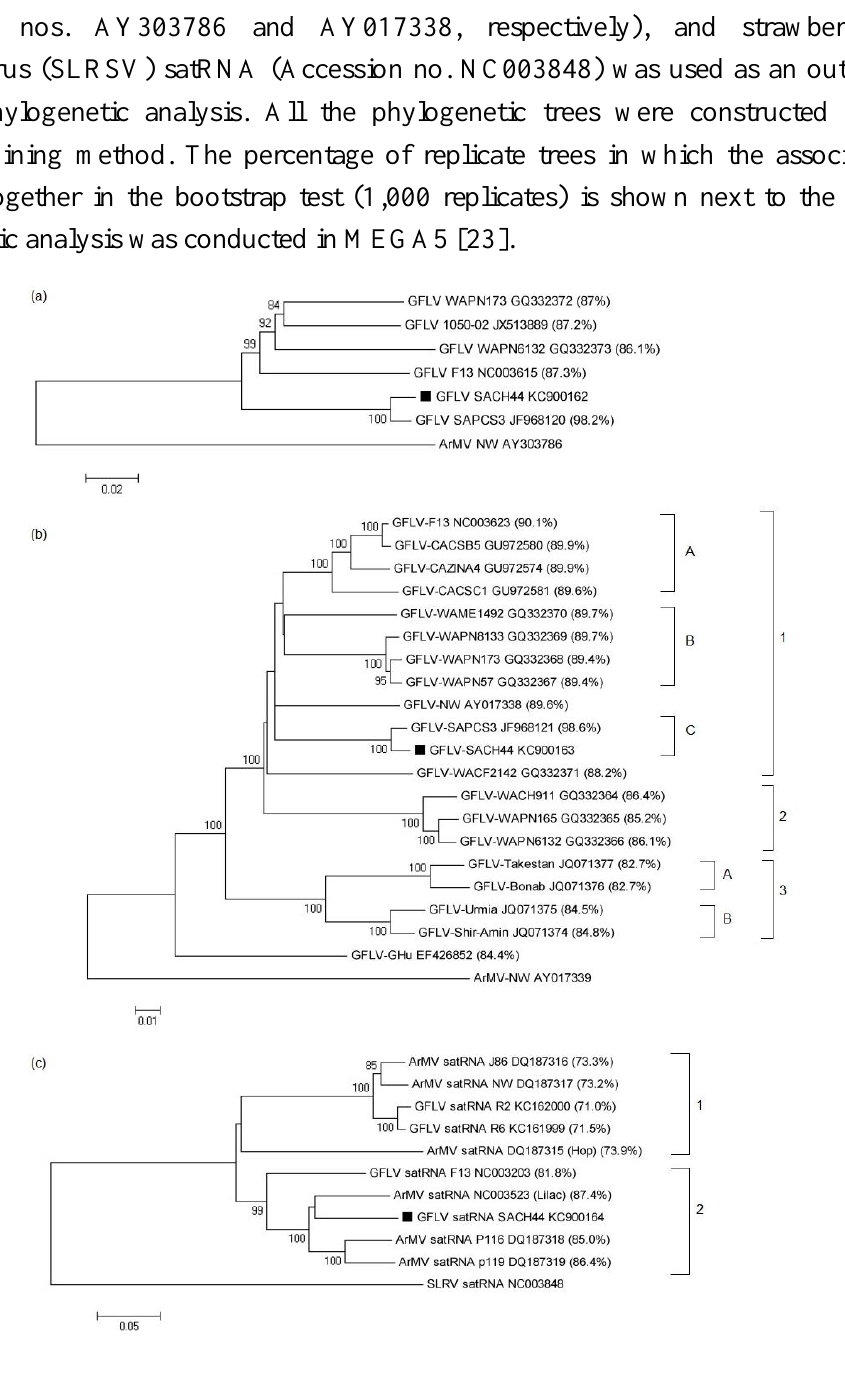
Figure 1. Phylogenetic trees based on full-length nucleotide sequences of ( a ) RNA1 of GFLV isolates; ( b ) RNA2 of GFLV isolates; and ( c ) satRNAs of GFLV and ArMV isolates. The nucleotide identities between GFLV-SACH44 and other GFLV or ArMV isolates are indicated in brackets. The accession numbers of the isolates are indicated